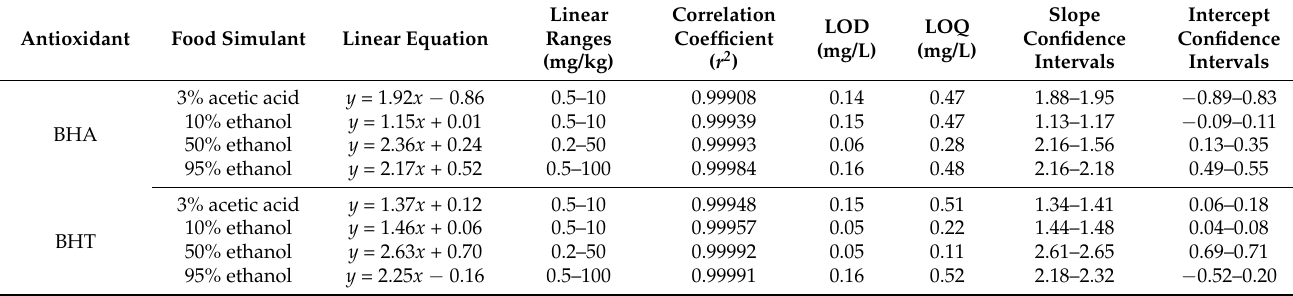
Table 7. Linear equations, LOD, and LOQ of BHA and